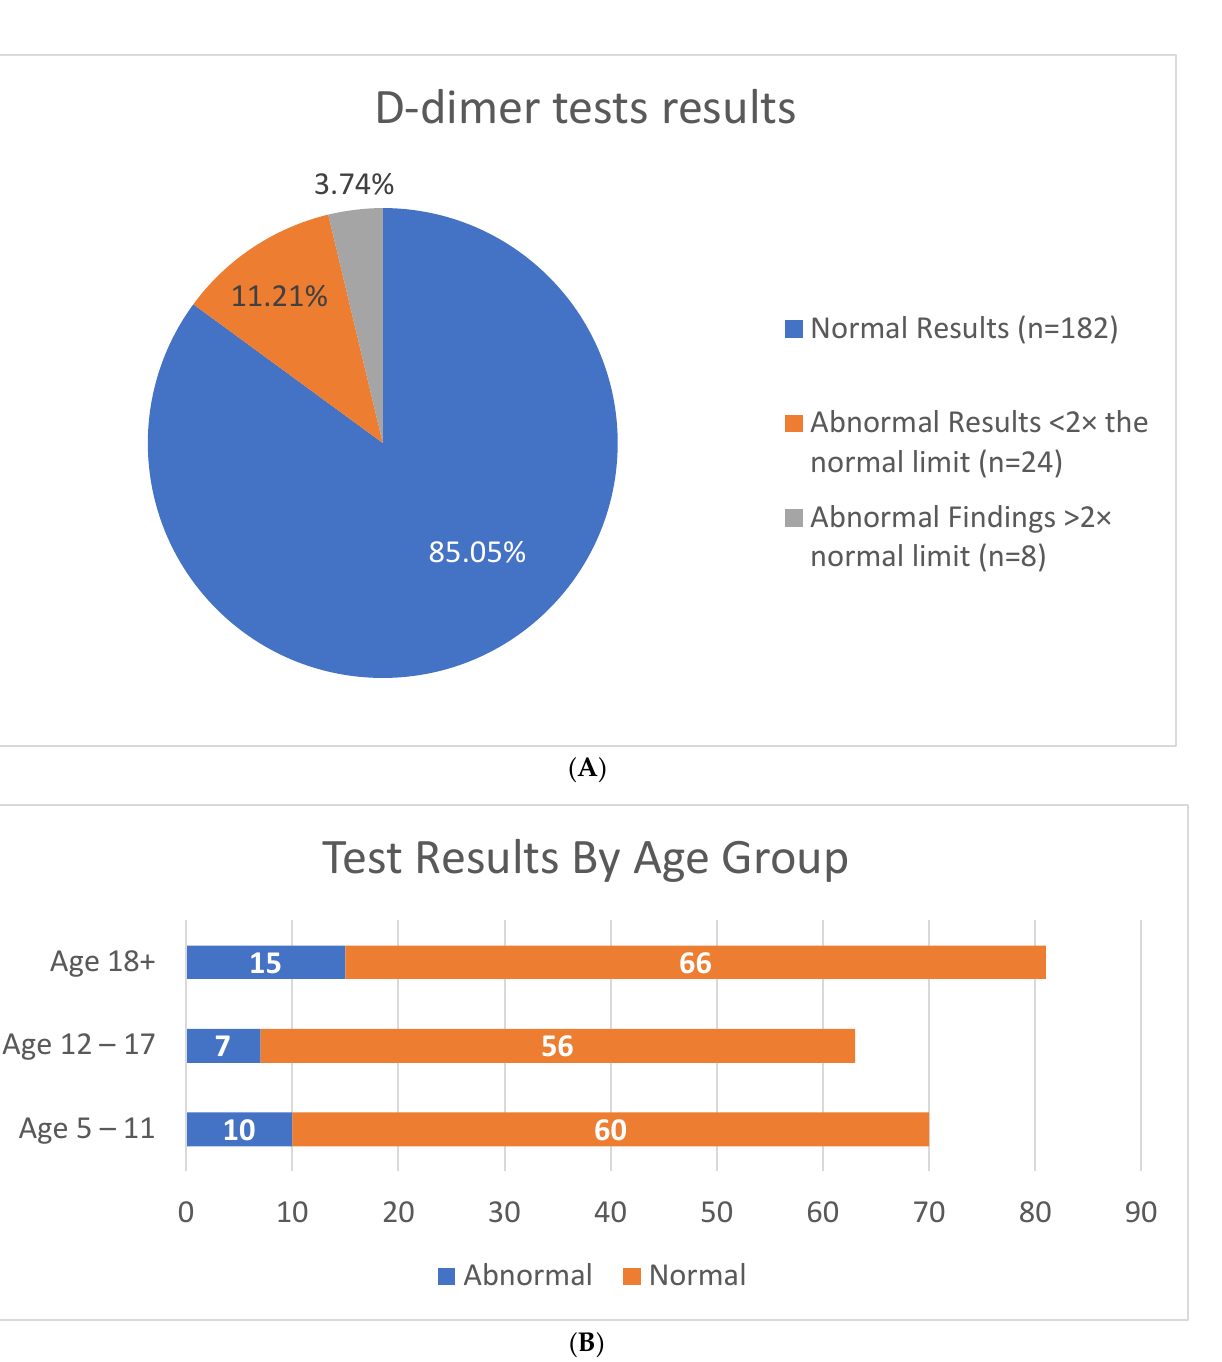
Figure 4. Laboratory findings of D-dimer concentration in 214 individuals with PWS. ( A ) Overall results showing number of participants with abnormal D-dimer findings. ( B ) Distribution of abnormal D-dimer results in different age categories.